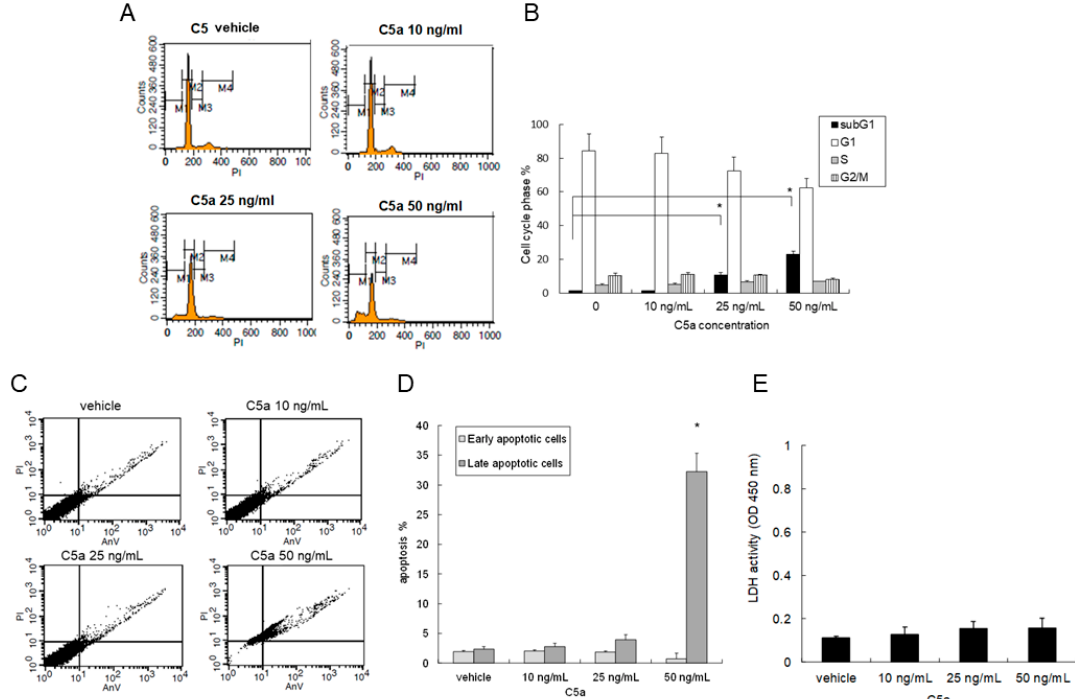
Figure 2. High-dose C5a treatment induced the apoptosis of mouse KECs. ( A ) Mouse KECs were treated with 0–50 ng/mL of rmC5a for 48 h. The cell cycle phases including apoptosis (sub-G1 phase) were analyzed by PI staining and flow cytometry. ( B ) The data are represented as mean ± SD. * p < 0.05. ( C ) Mouse KECs were treated with 0–50 ng/mL of rmC5a for 48 h. The early and late stage cytometry. ( D ) The quantitative data are represented as mean ± SD. * P < 0.05. ( E ) The